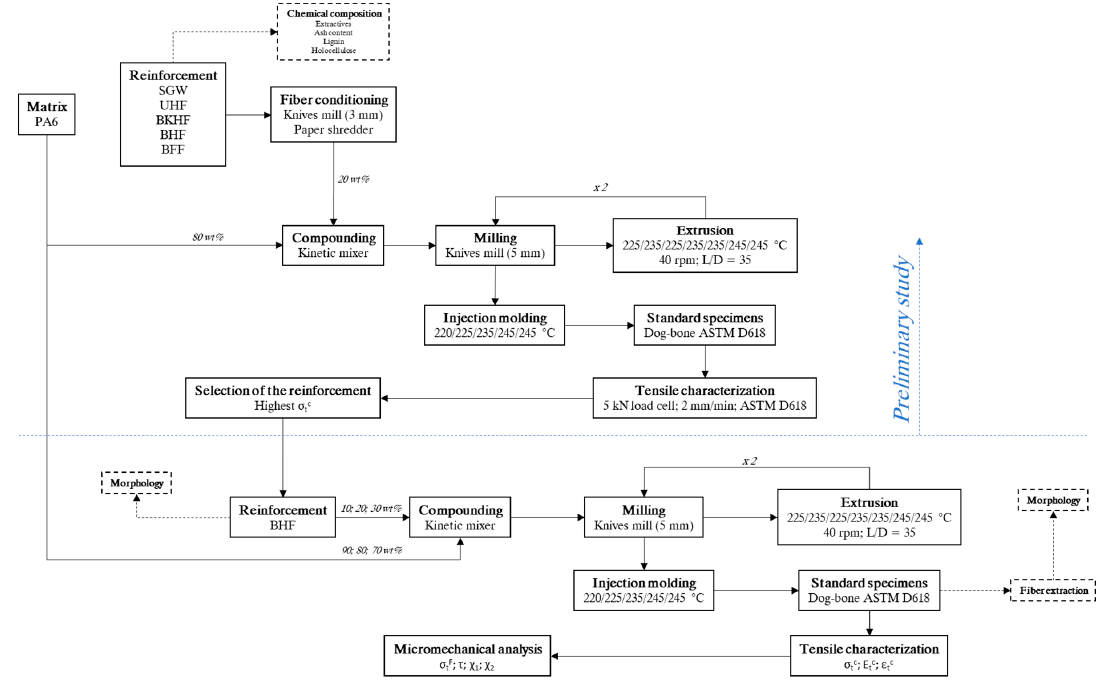
Figure 1. Workflow of the present study.